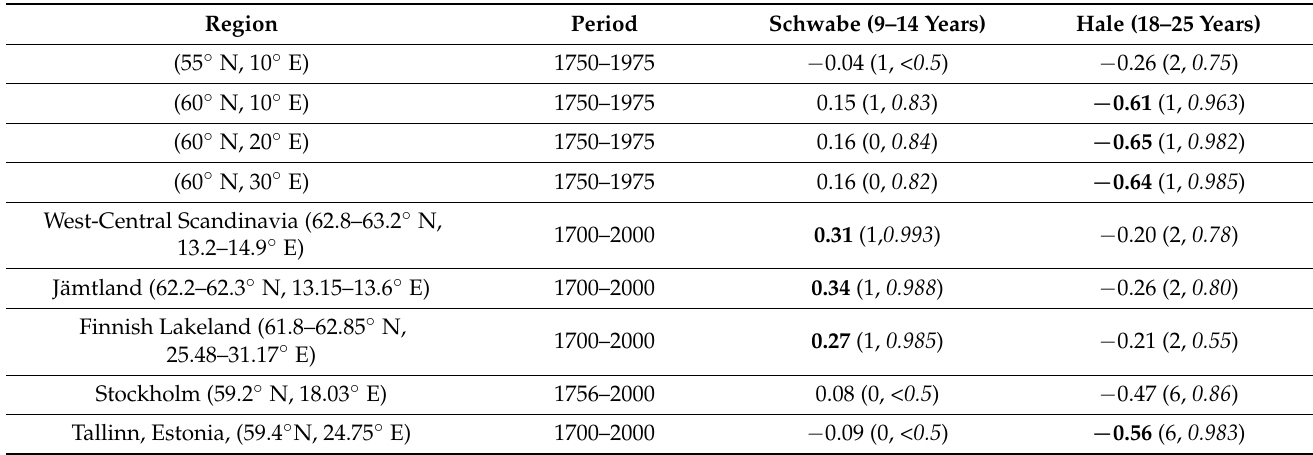
Table 3. Correlation between the Southern Scandinavian temperature proxy records and solar activity data filtered using the Schwabe (8.6–14.1 years) and Hale (18.1–25.3 years) scale bands. The correlation coefficients with the significance exceeding 0.95, are shown with large font size. Phase shifts (forcing data leading the temperature data) in years are shown in the brackets, with the significance in italics, also in the